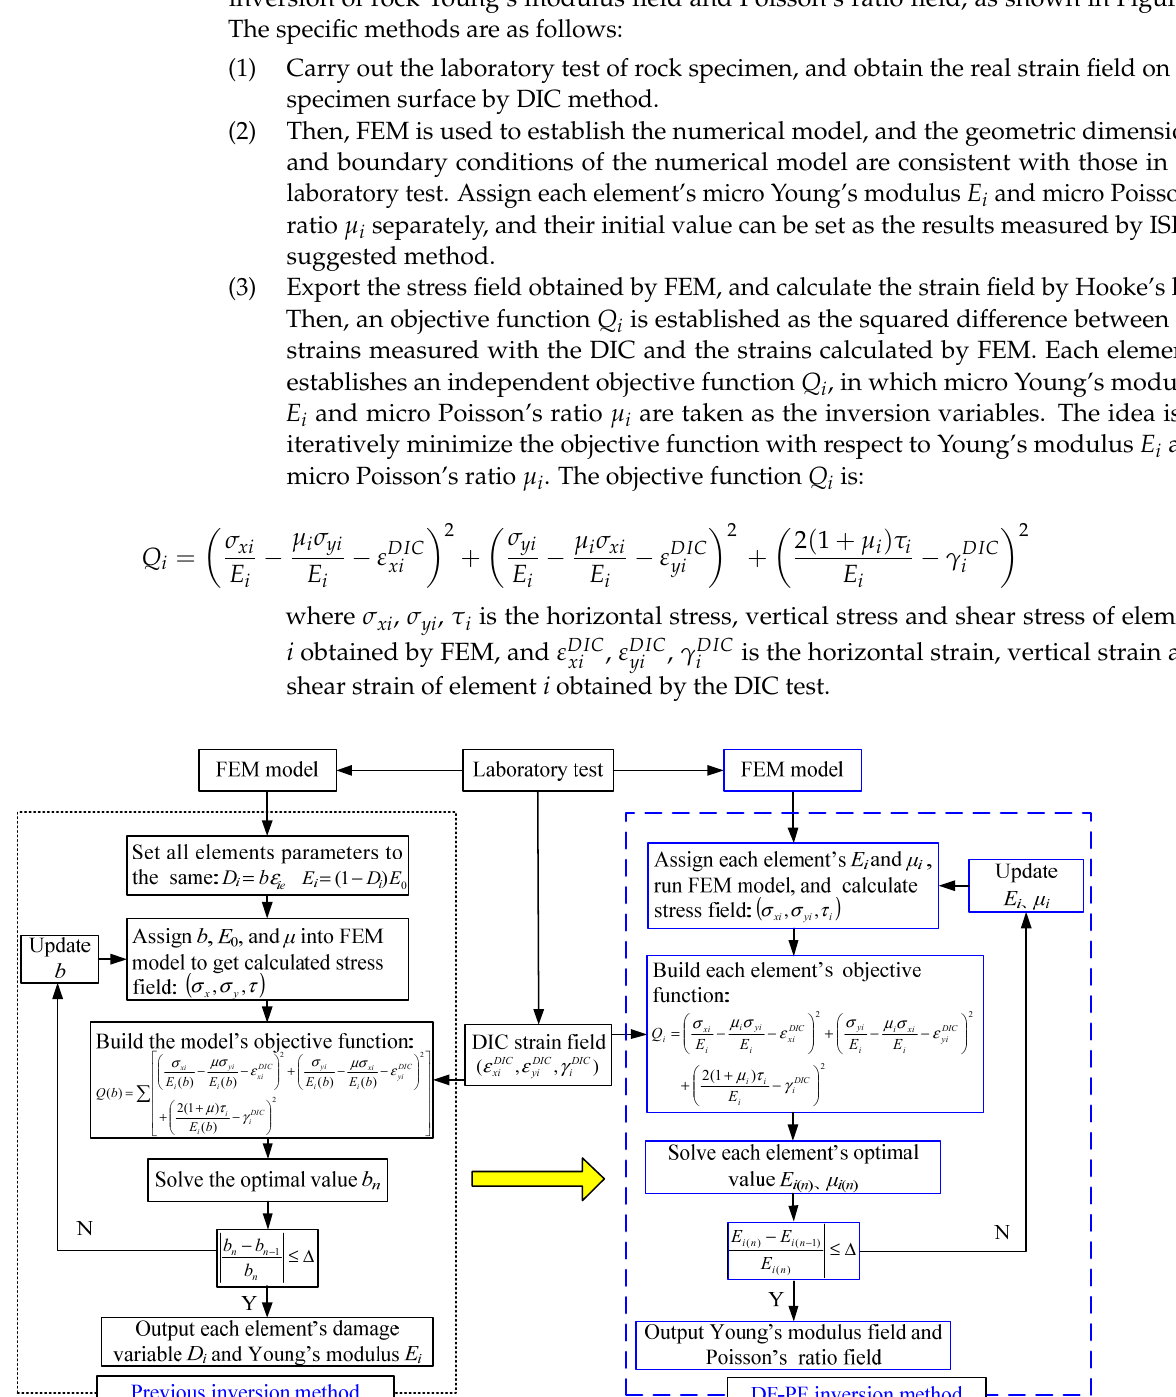
method for unconstrained optimization problems without requiring gradient